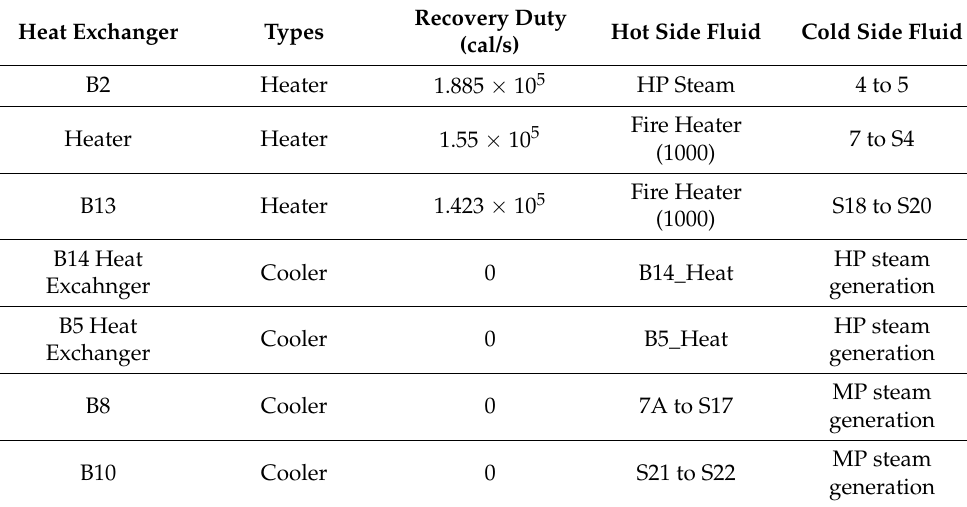
Table 4. Pinch analysis and temperature interval